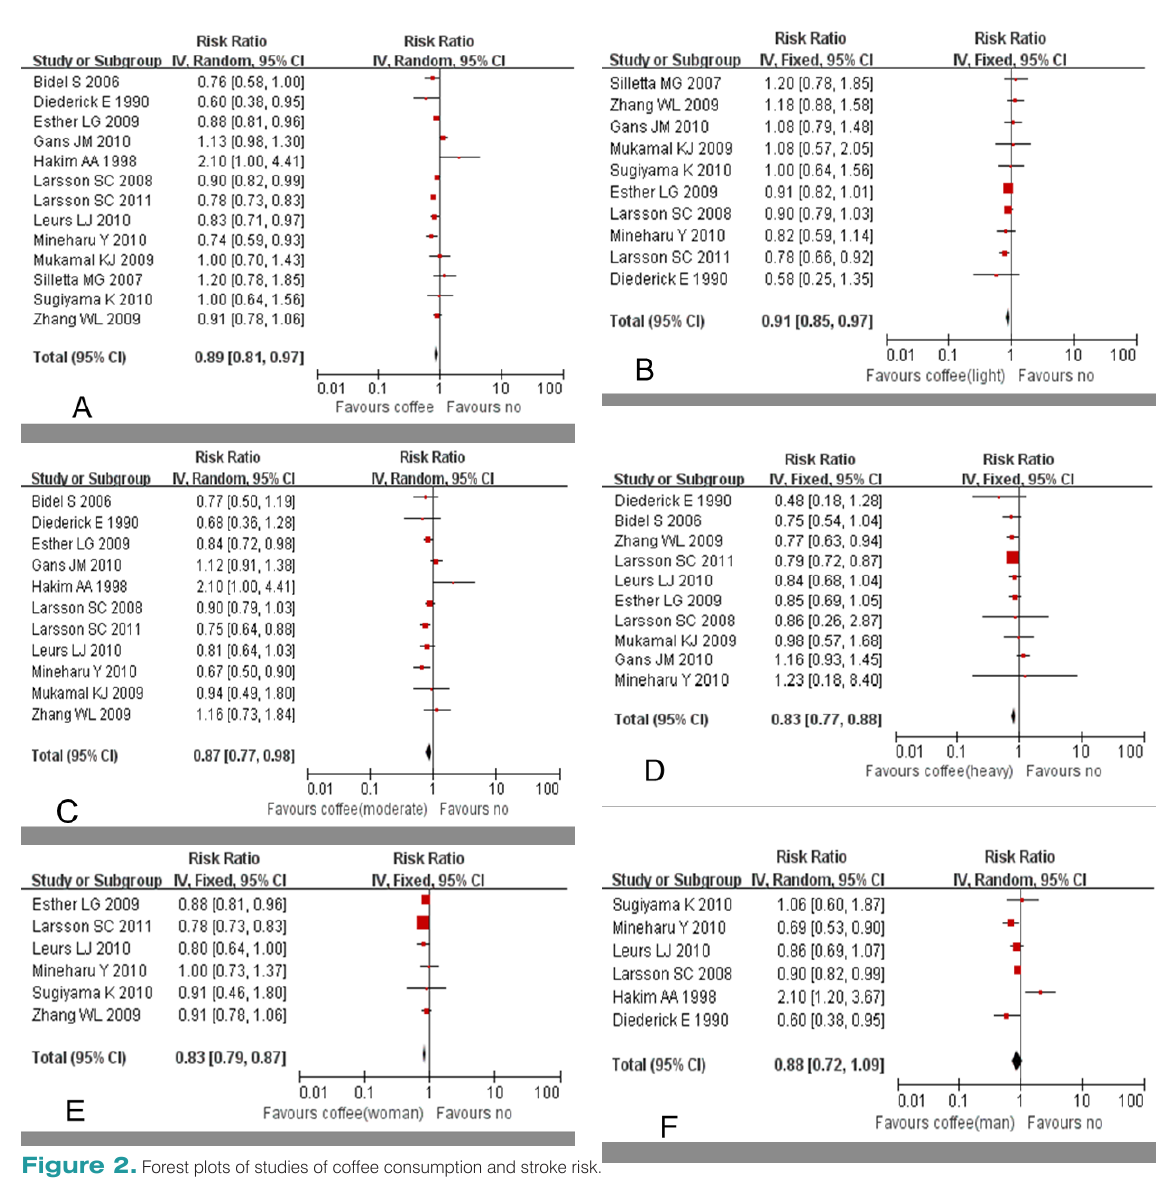
Figure 2. Forest plots of studies of coffee consumption and stroke risk. A: total coffee consumption vs non coffee consumption; B: light coffee consumption vs non coffee consumption; C: moderate